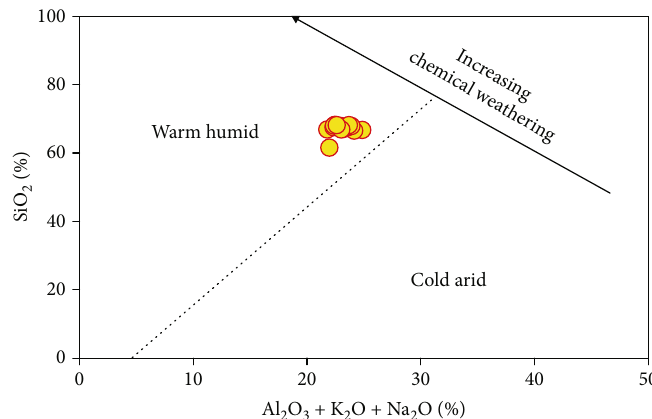
Figure 10: Discrimination diagram of SiO